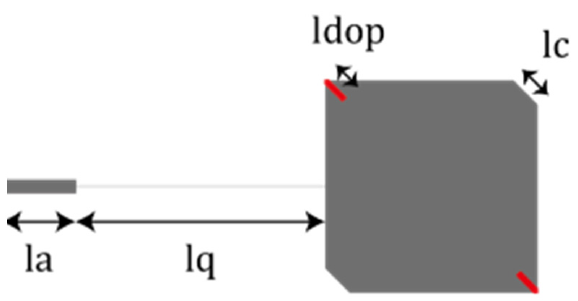
Figure 10. A top view of the circular to linear polarization switchable antenna design.